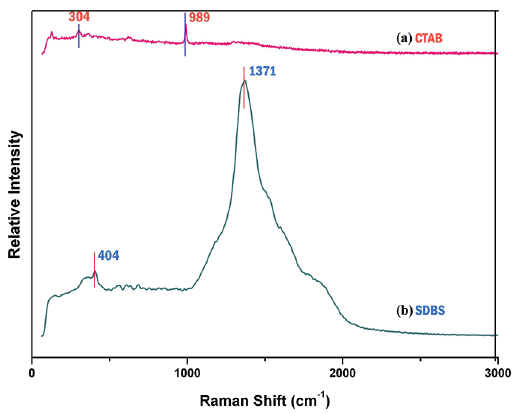
O samples capped with CTAB 2 3